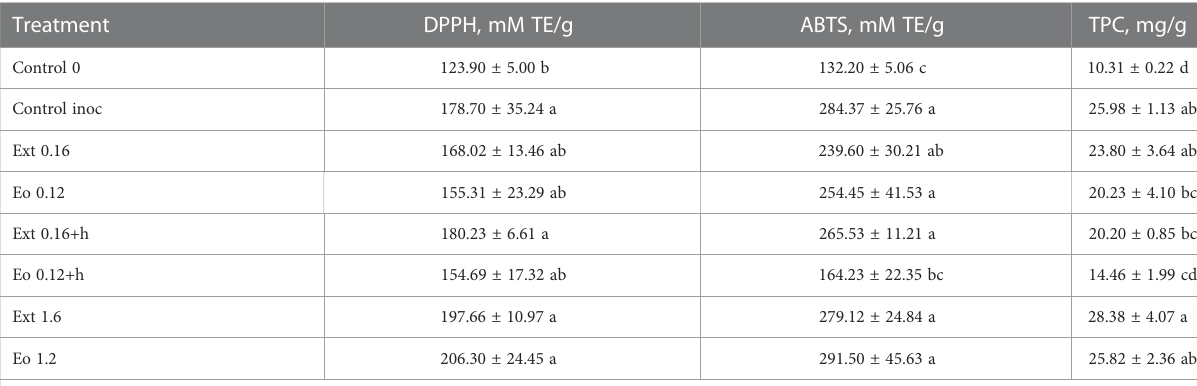
Values are mean±SE of 3 replicates. Different letters indicate signi fi cant differences between the means of the treatments (Tukey ’ s signi fi cant difference test, p <